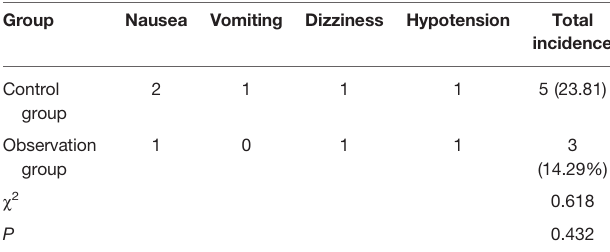
TABLE 2 | Adverse reactions of the two groups.